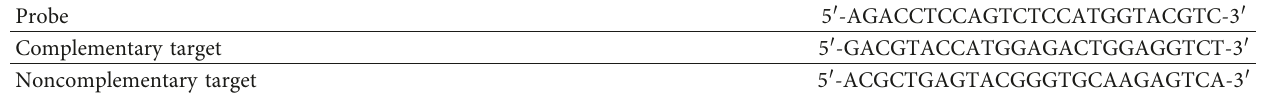
Table 1: The probe and target DNA sequences used in this